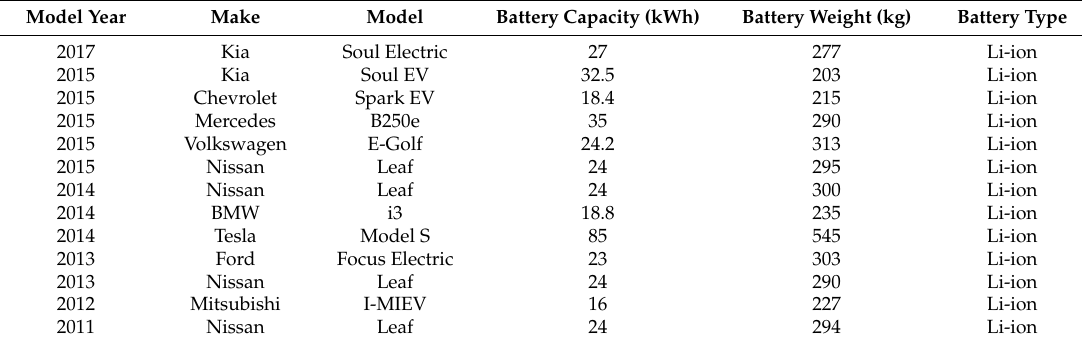
Table A4. Vehicle data for battery capacity vs. battery weight (Figure